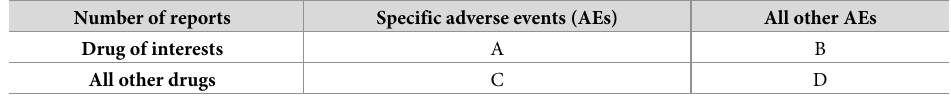
Table 1. Two-by-two contingency table of adverse events (AEs) of the drugs of interest. Number of reports All other drugs